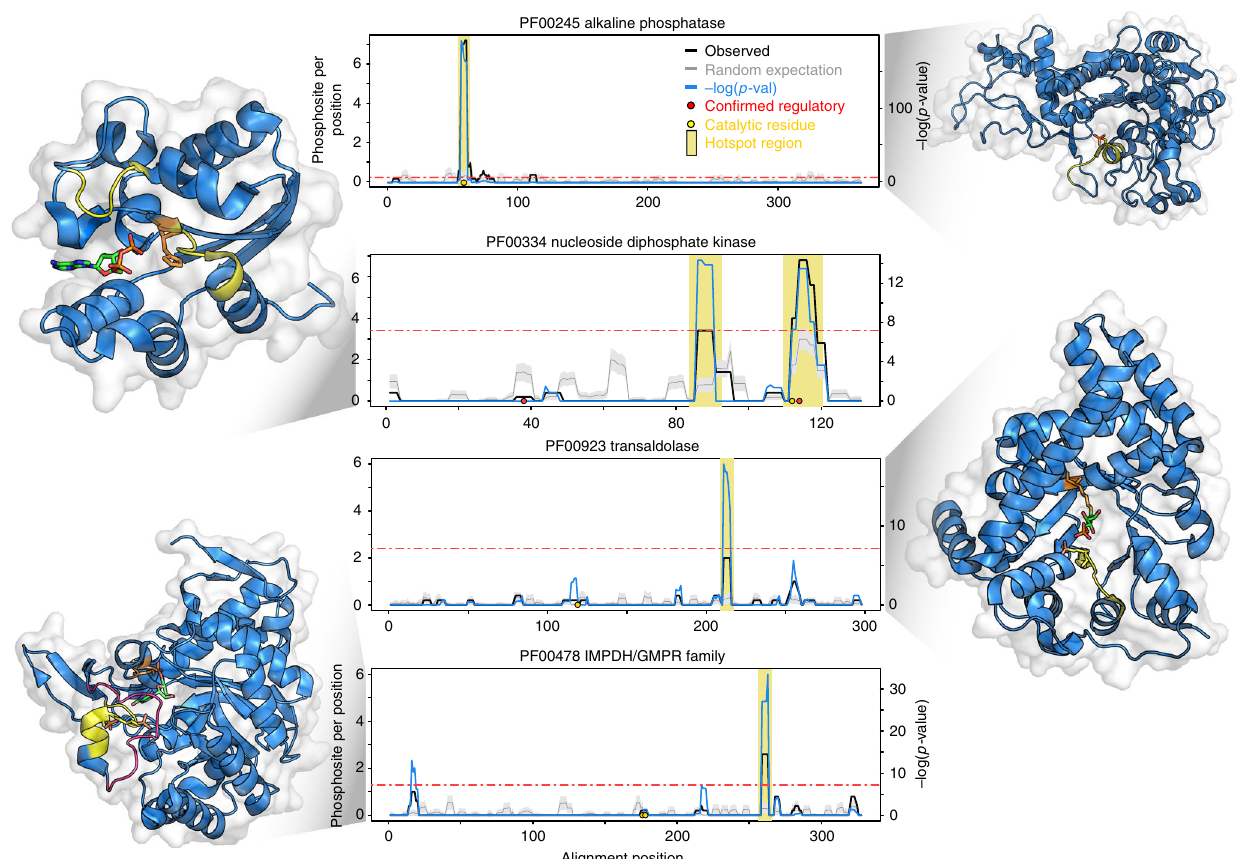
Fig. 4 Examples of putative regulatory hotspots at or near catalytic residues. The average number of phosphosites observed per rolling window is plotted in a solid black line (observed). The background level of randomly expected phosphorylation is shown in gray line, with standard deviations as gray band. The blue line represents the negative logarithm of p -value at each position (right y axis). A horizontal red line indicates a cut-off of the Bonferroni corrected p - value of 0.05. Positions with a − log( p -value) above this cut-off and average phosphosites per window higher than 2 are considered putative regulatory regions and highlighted under the yellow bar. Red circles indicate human phosphosite positions with known regulatory function and yellow circles represent catalytic residue positions. In the structural representations the predicted hotspot regions are highlighted in yellow. The catalytic residues have been represented in as orange sticks and in red stick representations are substrates or